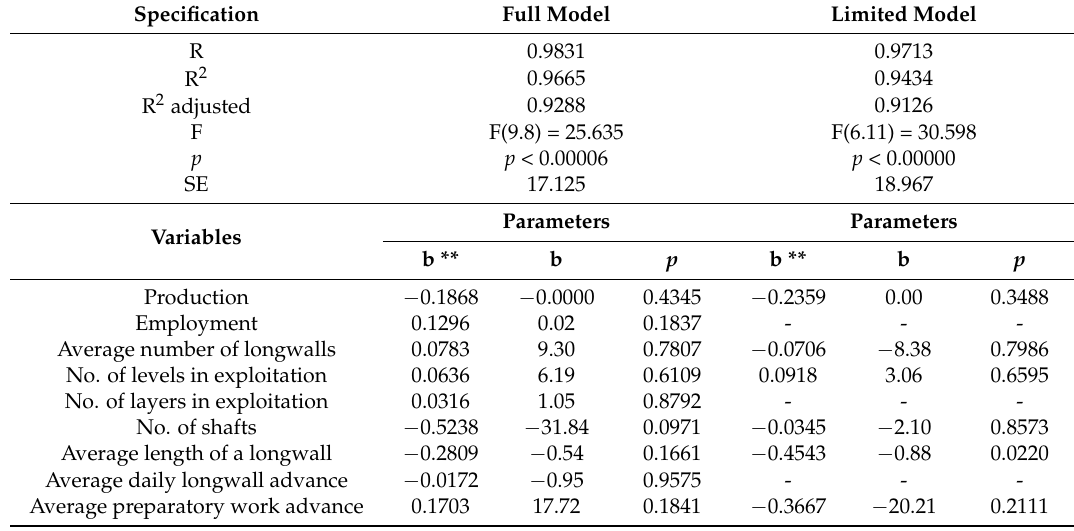
Table 3. Regression models for CM2.